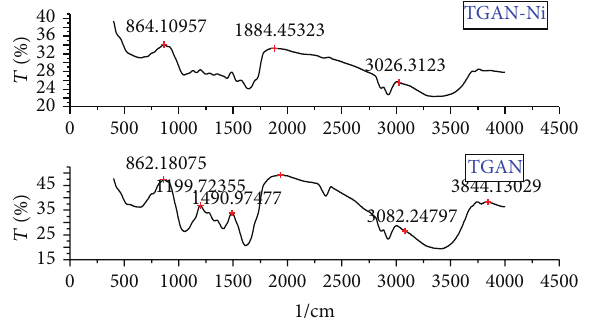
Figure 2: FTIR analysis of TGAN and TGAN-Ni.